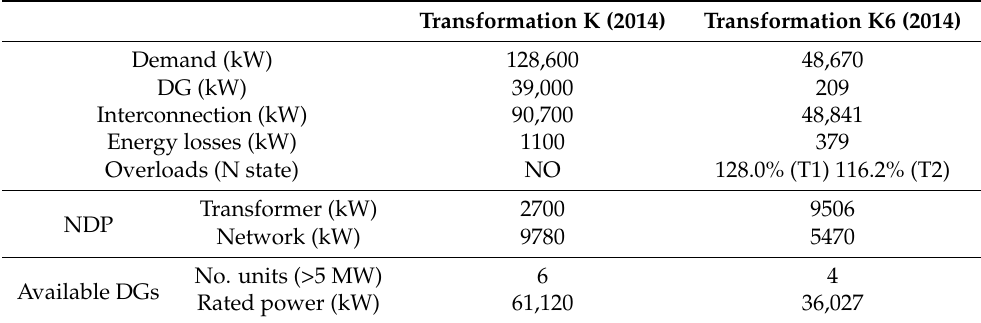
Table 1. Transformations K and K6 power flow and contingency analysis results for the aggregated base case.